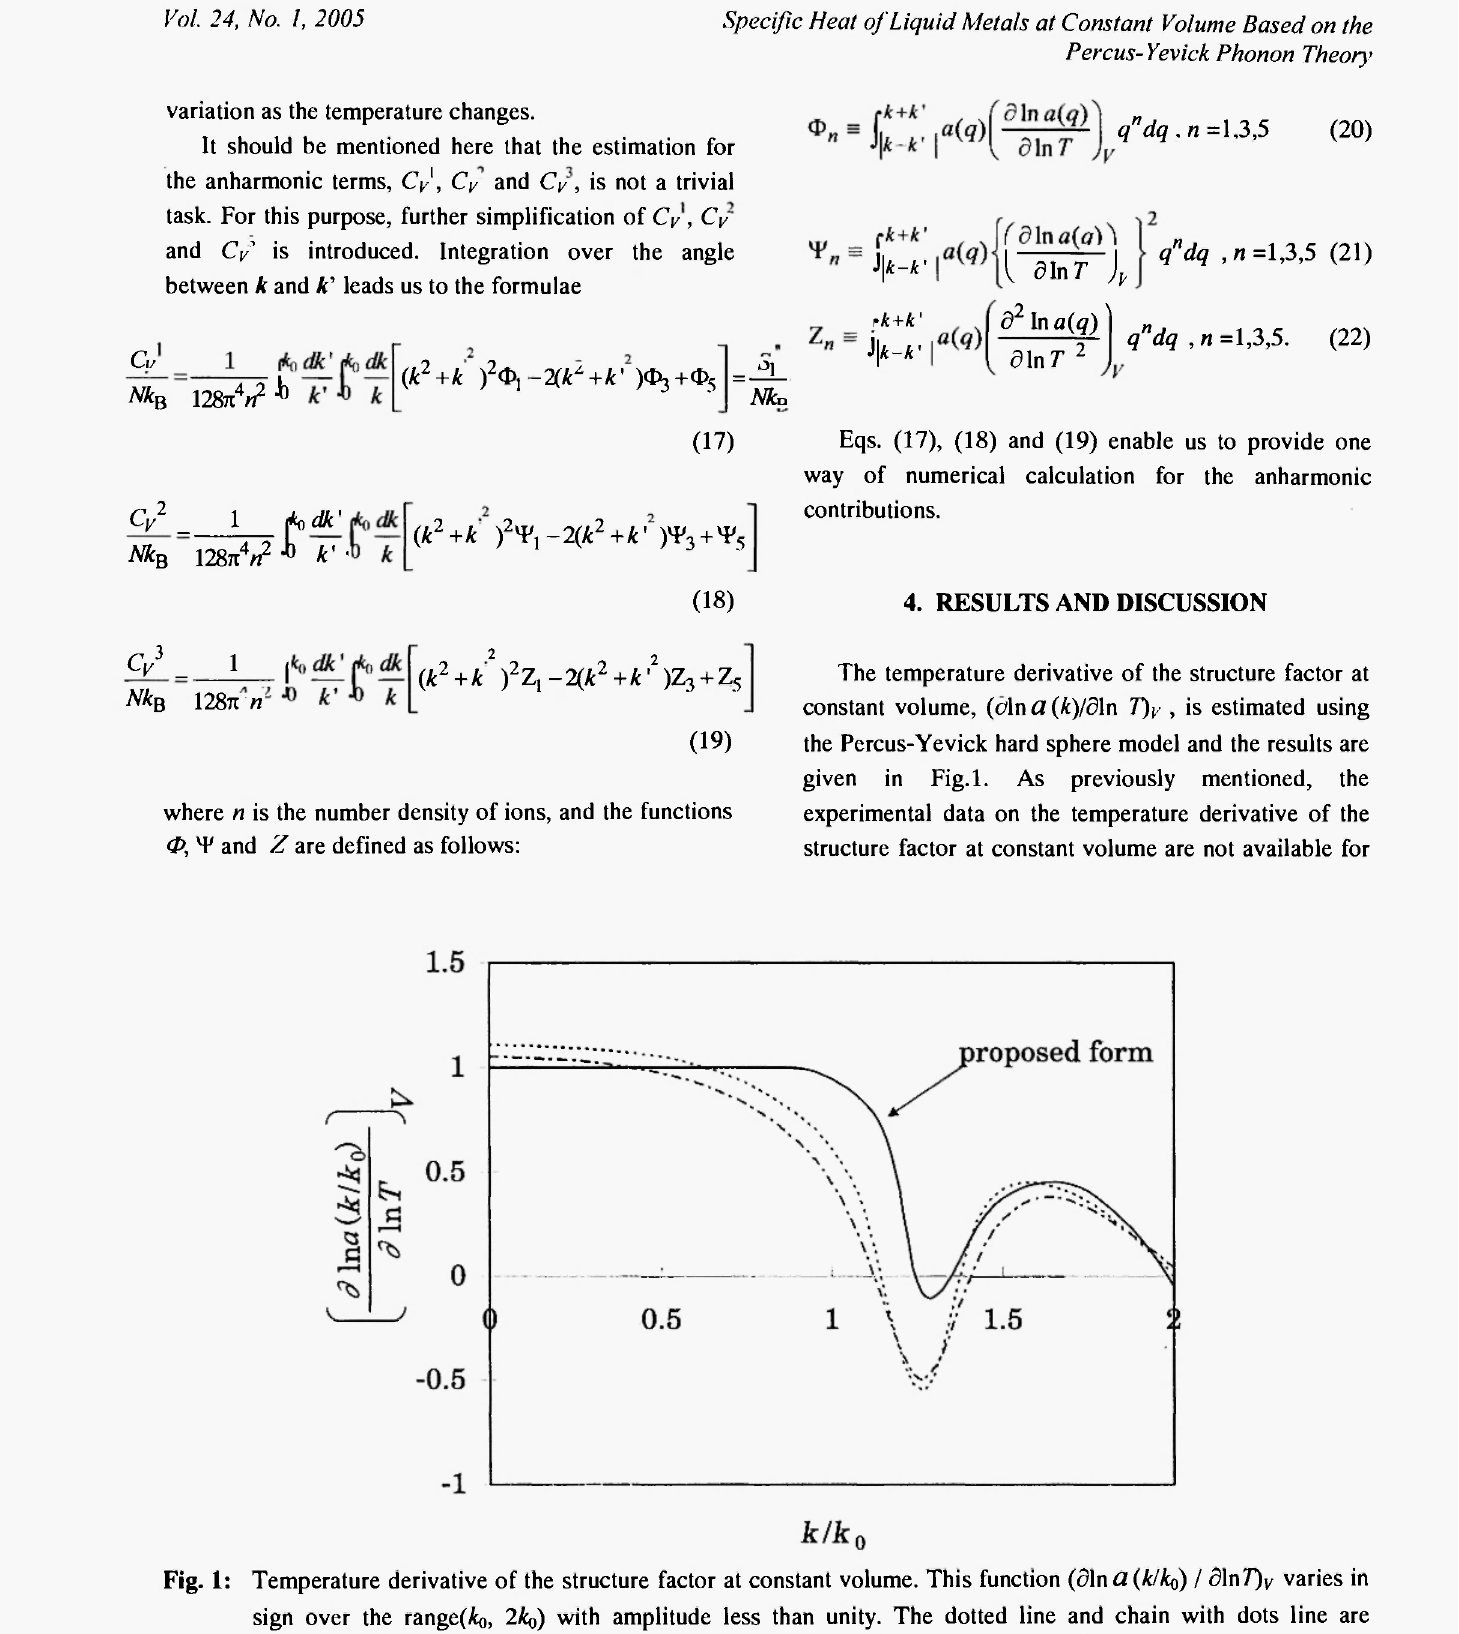
Fig. 1: Temperature derivative of the structure factor at constant volume. This function (din a(k/^) / d\r\T) v varies in sign over the ranged, 2k^) with amplitude less than unity. The dotted line and chain with dots line are obtained by the hard-sphere structure factor with the packing fractions ξ =0.45 and 0.40, respectively. The full line denotes the proposed form for alkali metals near the melting